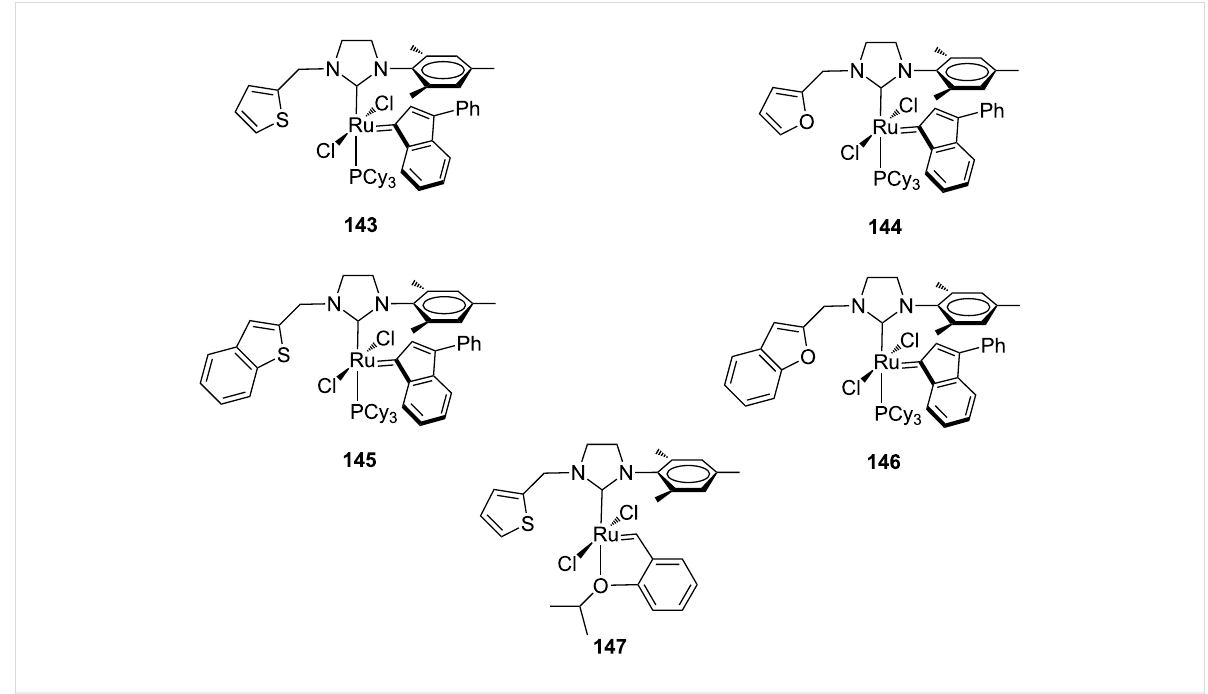
Figure 27: Indenylidene ( 143 – 146 ) and Hoveyda-type ( 147 ) complexes with N -heteroarylmethyl, N’ -mesityl NHCs.